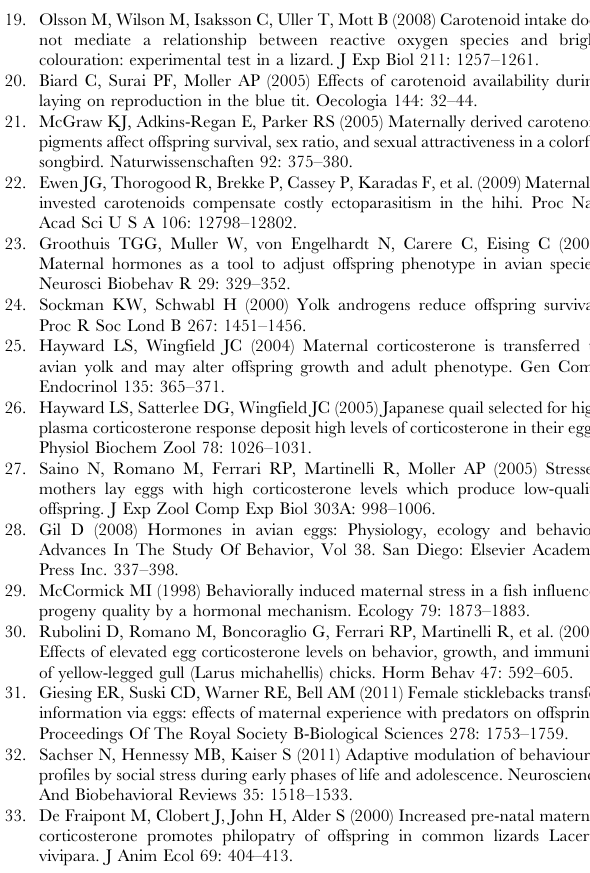
Figure S1 Non-significant relationships between group size and fledgling mass without and after controlling for egg